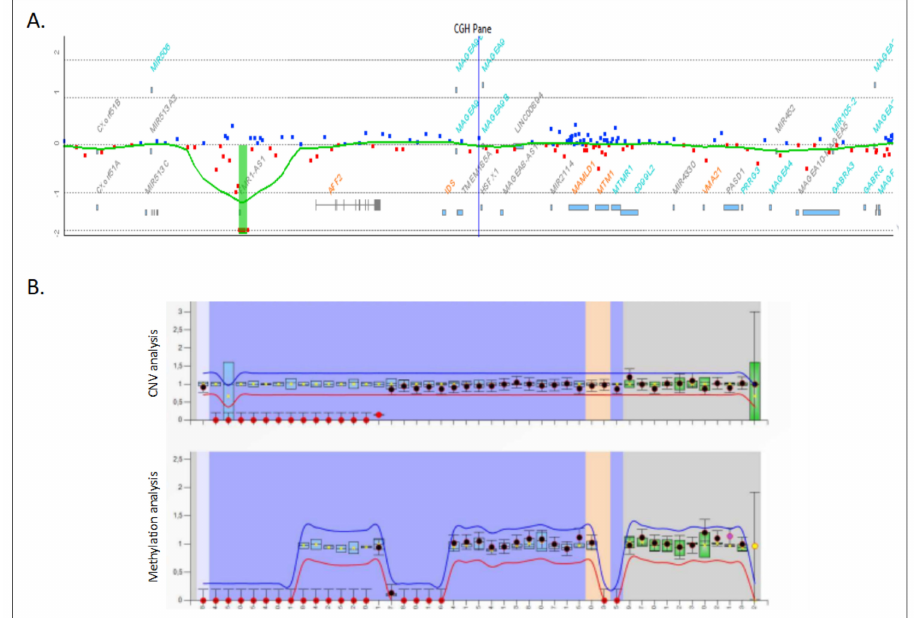
Figure 2. Genetic analysis of the index case. ( A ) FMR1 gene deletion detected by a chromosomal microarray. ( B ) Validation of the FMR1 gene deletion by means of an MLPA using SALSA ME029.